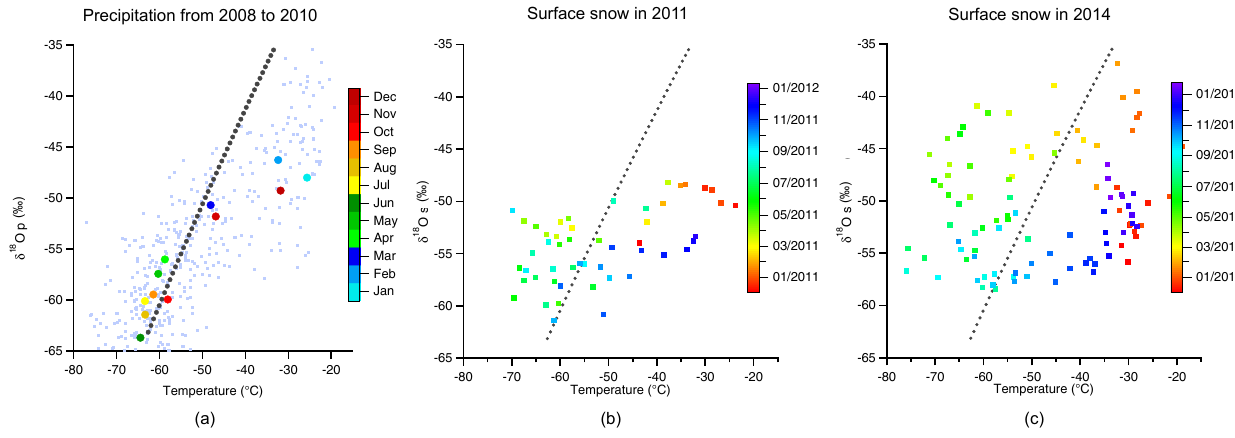
Figure 10. (a) 2008 to 2010 isotopic composition of precipitation versus temperature, showing daily averaged values from 3m (light blue squares), monthly means (coloured circles) and Mixed Cloud Isotope Model (MCIM) outputs (black dotted line); panels (b) and (c) show the isotopic composition of surface snow versus daily average of 3m temperature for 2011 and 2014, respectively.